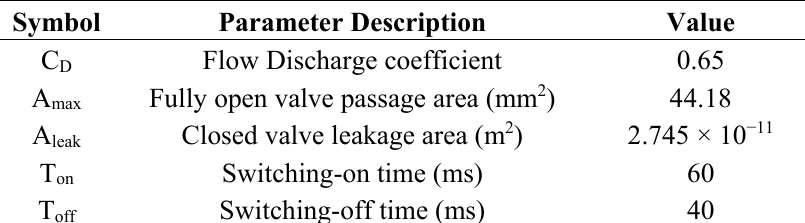
Table 3. Valve block main parameters.